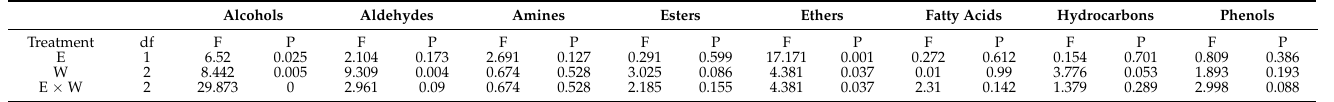
Figure 1. The proportion of alcohols ( a ), aldehydes ( b ), amines ( c ), esters ( d ), ethers ( e ), fatty acids ( f ), hydrocarbons ( g ), and phenols ( h ) of leaf cuticular wax in Achnatherum inebrians under the status of Epichloë gansuensis endophyte and different soil moisture content (D: drought, N: normal, W: well-watered, EI: endophyte-infected and EF: endophyte-free). Values are means, with standard error bars ( n = 3). Columns with non-matching letters indicate a significant difference at p < 0.05. Table 1. Two-way ANOVA analysis showing the effects of the status of Epichloë gansuensis endophyte (E) and different soil moisture content (W) on the wax compositions of the leaves of Achnatherum inebrians (df: degree of freedom, F: F-value, and P: p -value). Aldehydes Amines Esters Ethers FattyAcids